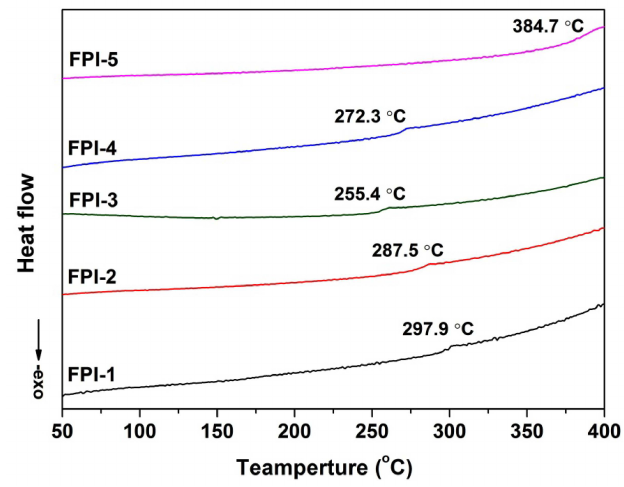
Figure 9. DSC plots of FPI